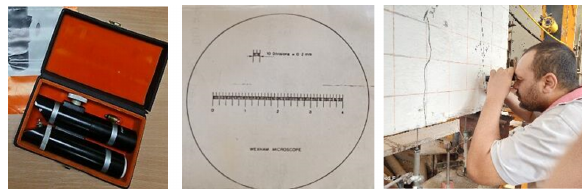
Figure 14: Wexham microscope and cracks width measurement